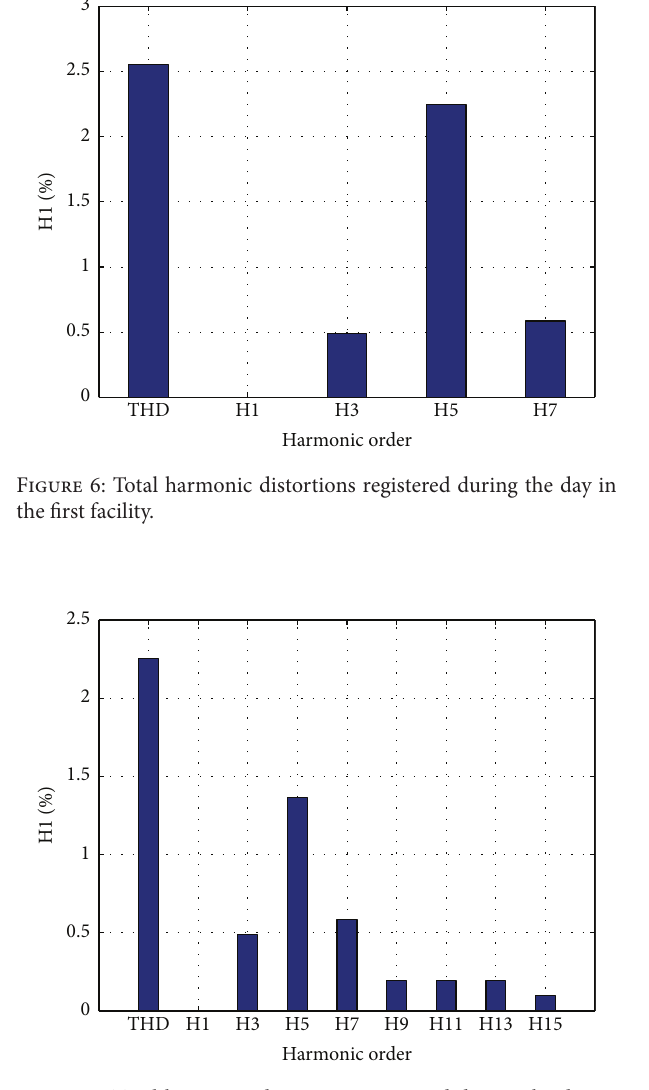
Figure 7: Total harmonic distortions registered during the day in the second